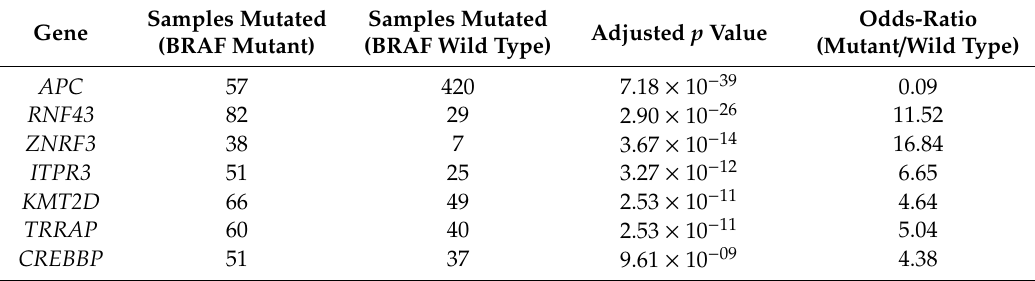
Figure 5. The mutational landscape of WNT signaling regulators in BRAF wild type cancers. Table 2. Comparison of the mutational frequency of WNT signaling regulators in BRAF mutant cancers versus BRAF wild type